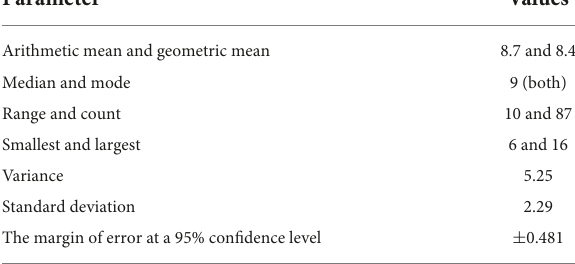
TABLE 1 The statistical analysis of the selected population of 87